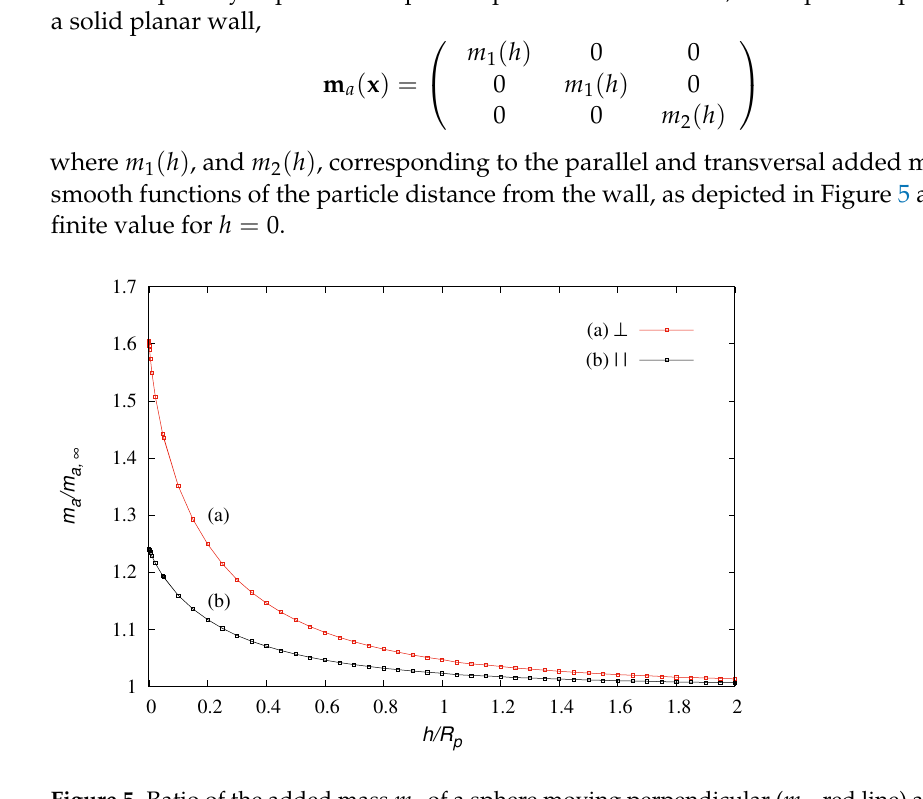
Figure 5. Ratio of the added mass m a of a sphere moving perpendicular ( m 2 , red line) and parallel ( m 1 , black line) to a planar wall to that in an unbounded fluid m a , ∞ = ( 2/3 ) πρ R 3 p obtained by FEM